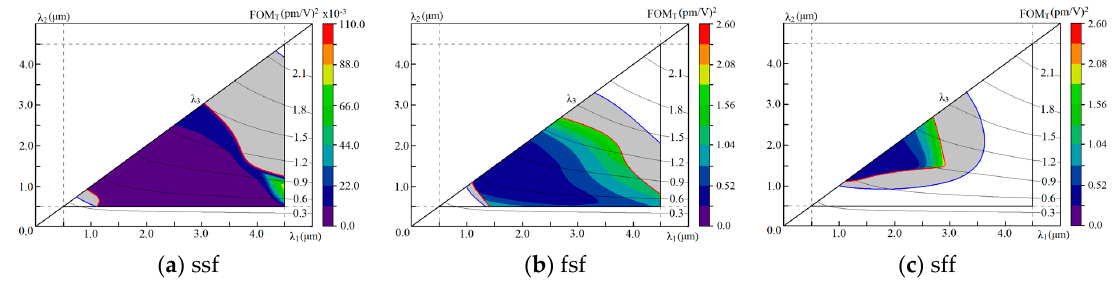
Figure 17. FOM T ( λ 1 , λ 2 ) distribution for KTP crystal for all types of interactions with data on dn i / d T from [49]: ( a ) ssf , ( b ) fsf , ( c ) sff.